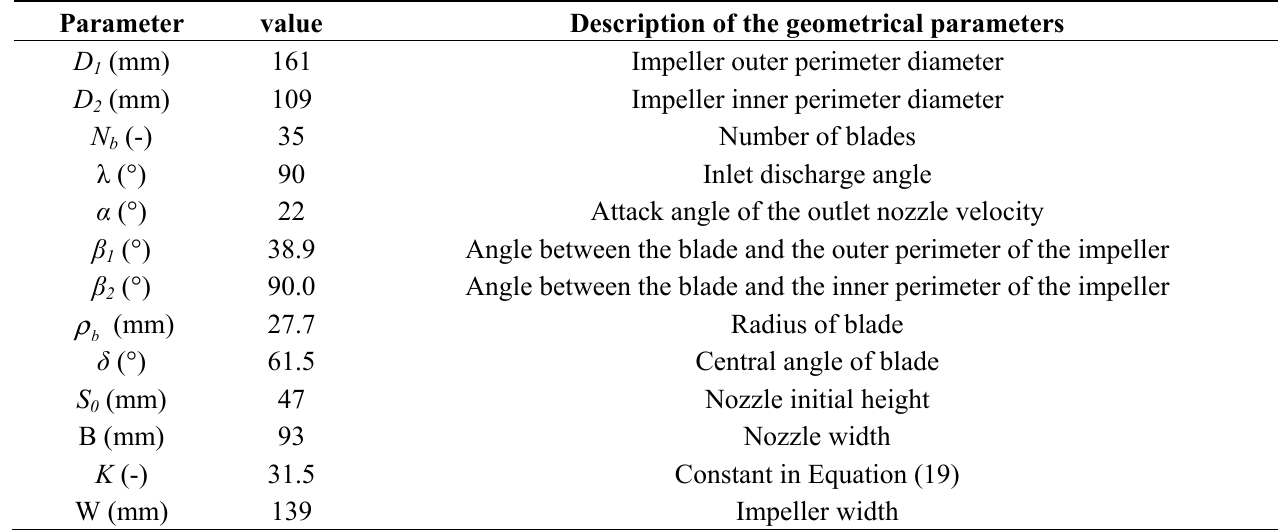
Table 2. Geometrical parameters of the